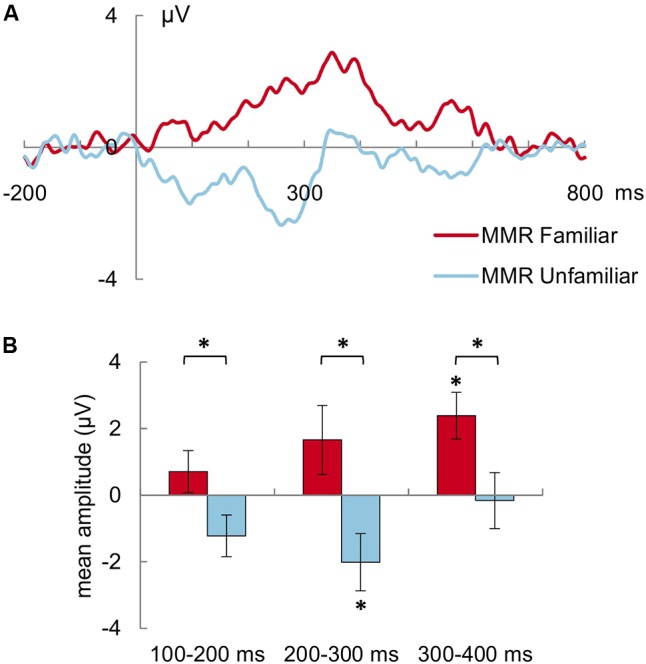
(A) Mismatch Responses (MMR) to the familiar (red/dark gray line) and unfamiliar voice (blue/light gray line) averaged across all frontal and central electrode sites and all subjects. (The MMR is determined by the difference between the ERPs to the familiar and unfamiliar deviant, respectively, minus the ERP to the standard voice stimuli.) The mean potential from -200 pre-stimulus onset to 800 ms post-stimulus onset is shown. (B) Mean (±SEM) amplitude of the MMR to the familiar (red/dark gray) and unfamiliar (blue/light gray) deviant voices for the 100–200 ms, 200–300 ms, and 300–400 ms latency ranges. Asterisk above brackets indicates p < 0.05 for pairwise comparison between MMR to familiar vs. unfamiliar deviants. Asterisk on top of SEM bar indicates significant (p < 0.05) MMR, i.e., a significant difference between the ERP to the deviant stimulus as compared to the ERP to the standard stimulus. The MMR to the familiar deviant is more positive than the MMR to the unfamiliar stimulus. Compared with the ERP to standard stimuli, the MMR to familiar deviants expresses itself as significant positive shift in the 300–400 ms post-stimulus interval, whereas the MMR to the unfamiliar deviants expresses itself as significant negative shift in the 200–300 ms post-stimulus interval.